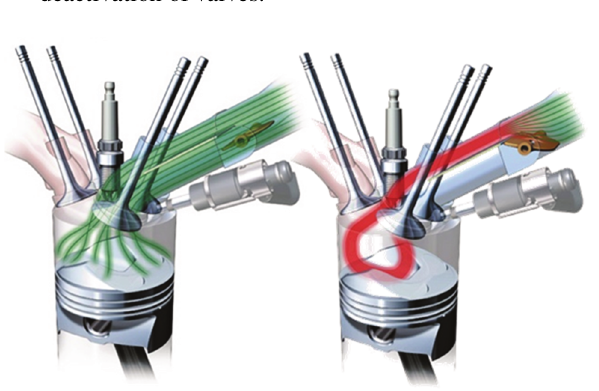
Fig. 2. The use of a turbulence generator in the form of a shutter in the inlet channel forcing a tumble motion of the gases (for example used in Audi 2.0 FSI engines) [15]